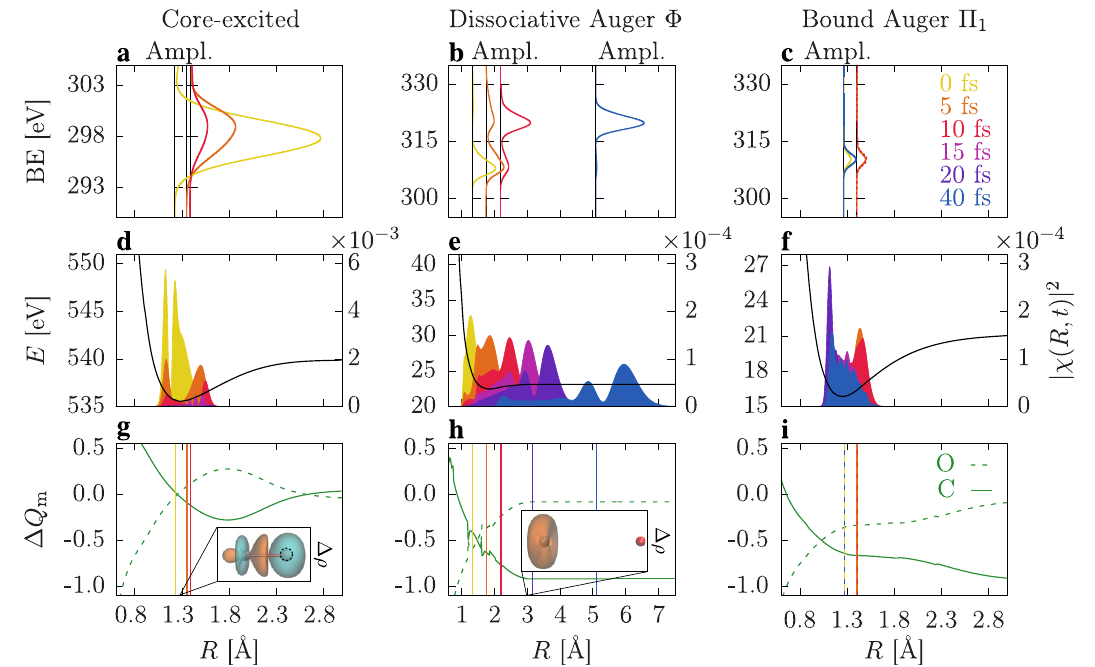
Δ Q m attheC(solidline)andO(dashedline)sites,betweenthecorrespondingstate and the ground state are shown in panels g – i . The average position of the nuclear wavepacket at different time delays is indicated as vertical bars. The electron density difference ( Δ ρ ) between the excited states and the ground state isgiven in the insets, where blue and orange densities correspond to gain and loss with respect to the ground state, respectively. The core vacancy at the O site is high- lighted by the dashed